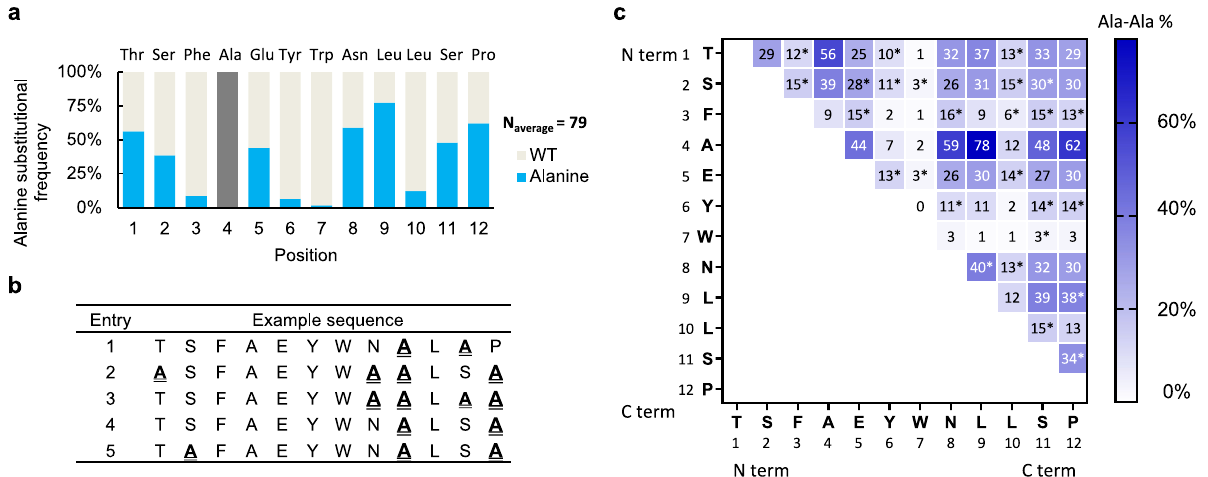
Fig. 2 Combinatorial alanine scanning of peptide PMI combined with af fi nity selection mass spectrometry identi fi es multi-alanine substituted variants. a 1-D single position alanine substitution frequency. The alanine tolerance was indicated by the single position alanine substitution frequency on the y -axis. Residues displaying low alanine substitution frequency (Phe3, Tyr6, Trp7 and Leu10) correspond to the hotspot residues. The x -axis indexes the PMI sequence from the N - to the C -terminus. Ala4 is excluded. b A subset of identi fi ed sequences from the af fi nity selections. c The pairwise alanine tolerance was indicated by the 2-D pairwise alanine substitution frequency matrix. Each box represents the pairwise alanine substitution frequency (Ala-Ala%) of two residues, calculated as the ratio of number of observed simultaneous pairwise alanine substitutions to the total number of identi fi ed sequences, expressed as Ala-Ala% = [( n Ala,Ala )/ n total ] × 100%. At 95% con fi dence level, 25 out of 55 total possible pairwise substitution frequencies are non-additive of single alanine frequencies. Non-additive pairs are marked with asterisks (*). Ala4 is excluded from the